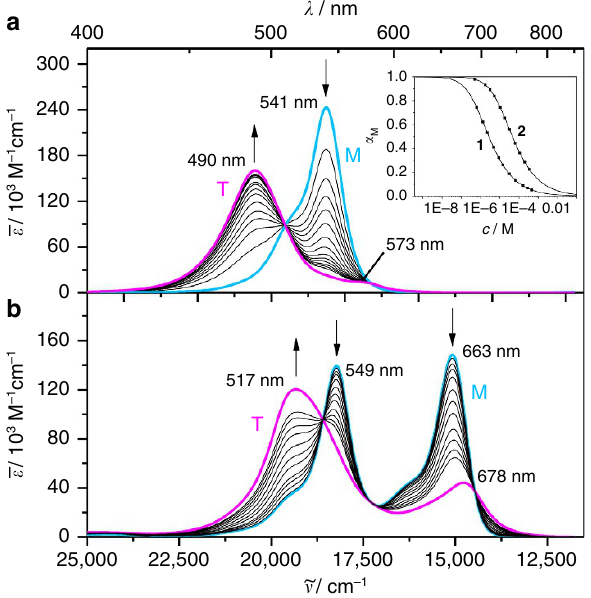
Figure 2 | UV/vis spectroscopic studies. Concentration-dependent UV/vis spectra of ( a ) bis(merocyanine) 1 ( c ¼ 4.4 (cid:2) 10 (cid:3) 7 –6.0 (cid:2) 10 (cid:3) 4 M) and ( b ) bis(merocyanine) 2 ( c ¼ 5.0 (cid:2) 10 (cid:3) 7 –3.4 (cid:2) 10 (cid:3) 4 M) in chlorobenzene at 298K. The arrows indicate the spectral changes upon increasing the concentration. The turquoise (denoted with M) and the magenta lines (denoted with T) represent the calculated spectra of the monomers and the tetrachromophoric (dimer) stacks, respectively, by extrapolation of the spectral data towards most diluted and most concentrated solutions. Inset in a : Plot of fractions of monomeric species a M against concentration and non-linear regression analysis of the data based on the dimerization model for bis(merocyanine) dyes 1 and 2 in